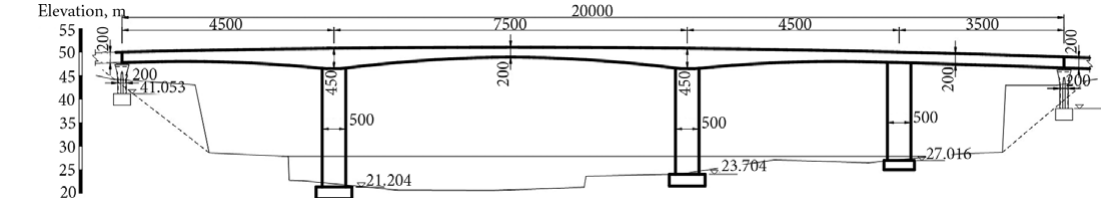
Fig. 12. Elevation diagram of